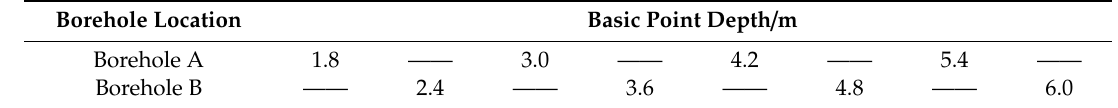
Table 2. Arrangement of displacement base point depth in high-density deep displacement monitoring of roof.